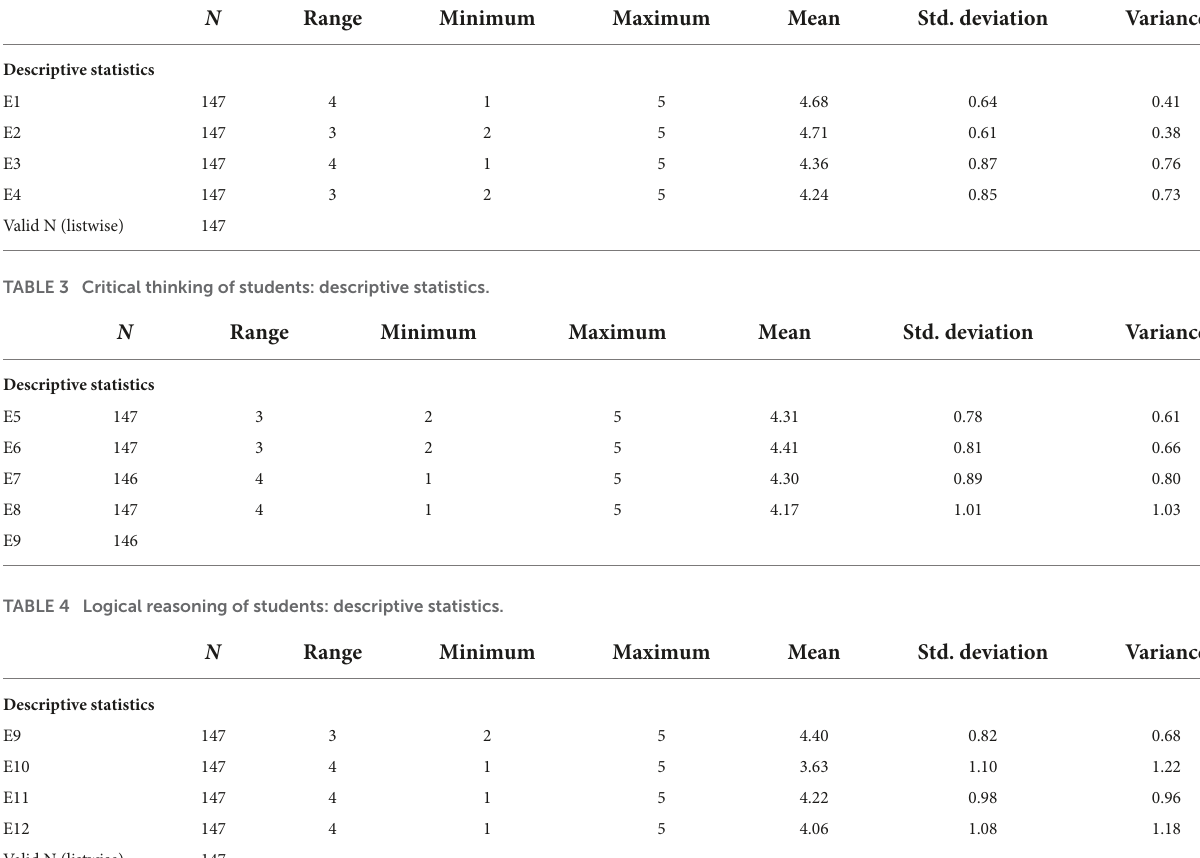
TABLE 2 Problem-solving abilities of students: descriptive statistics.